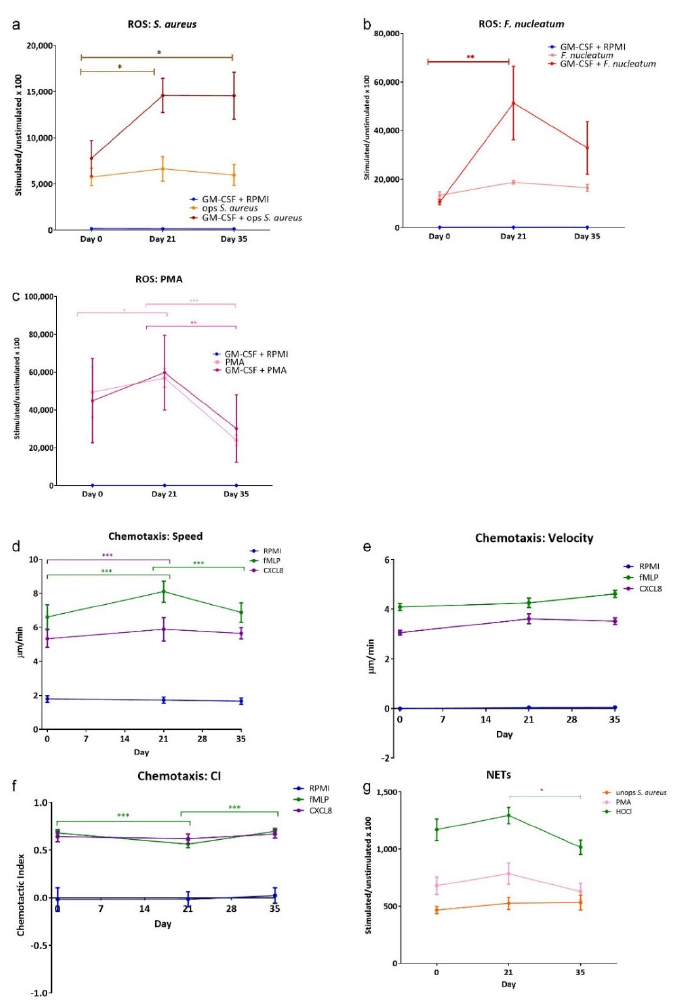
Figure 1. ROS, chemotaxis and NETs from gingivitis study volunteers. ROS production, chemotaxis and NET quantification in response to stimuli. Peak values for total ROS stimuli included: ( a ) opsonised S. aureus (MOI 1:300; Fc γ receptor stimulant); ( b ) F. nucleatum (MOI 300:1; TLR stimulant), ( c ) PMA (25 mM). Chemotaxis analysis was used to generate average ( d ) speed, ( e ) velocity and ( f ) chemotactic index (CI) for neutrophils from gingivitis study volunteers in the presence of RPMI (negative control), fMLP (10 nM) and CXCL8 (200 ng/mL) chemoattractants. NET production ( g ) was measured following stimulation with unopsonised S. aureus (MOI 150:1), PMA (50 nM) and HOCl (0.75 mM; direct stimulant). Average Relative Light Unit (RLU) and Arbitrary Fluorescent Unit (AFU) readings were normalised by dividing all values by the respective RPMI control for a given time point × 100. Data are presented as mean, min and max values ± standard error of the mean (SEM). Statistical test: ANOVA with Tukey’s post-test. * p < 0.05, ** p < 0.01 and *** p <